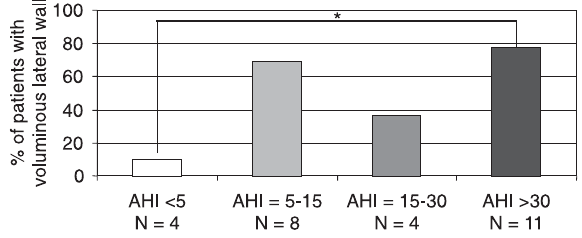
Figure 2. Upper airway anatomic abnormality (voluminous lat- eral wall) and severity of obstructive sleep apnea syndrome in class III obese patients. AHI = apnea-hypopnea index. *P = 0.04 (chi-square test).